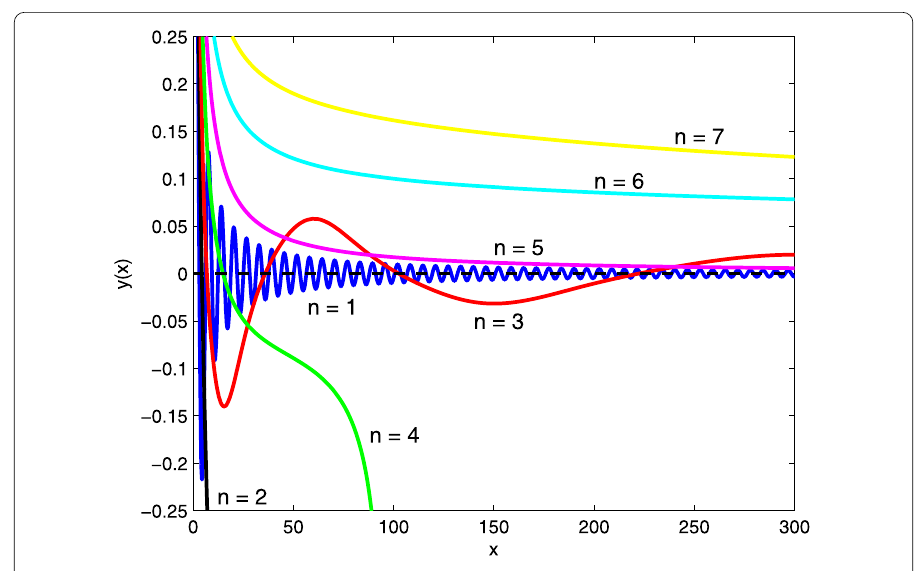
Figure 2 The numerical solutions of the spherical equation (8) with D = 3, integer n = 1 – 7, and boundary conditions y (0) = 1 and y (cid:2) (0) = 0. For n = 1 and n = 5, the solutions are also known analytically [10]. Surprisingly, the solution for n = 3 is the only nonlinear solution that is